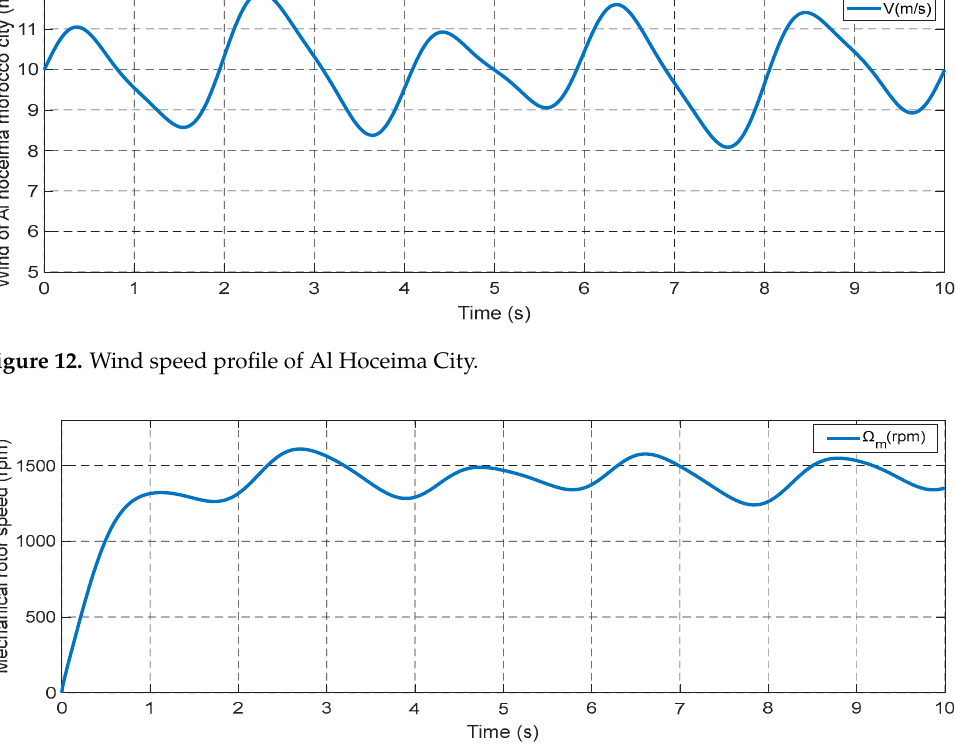
Figure 13. Mechanical rotor speed of the DFIG.